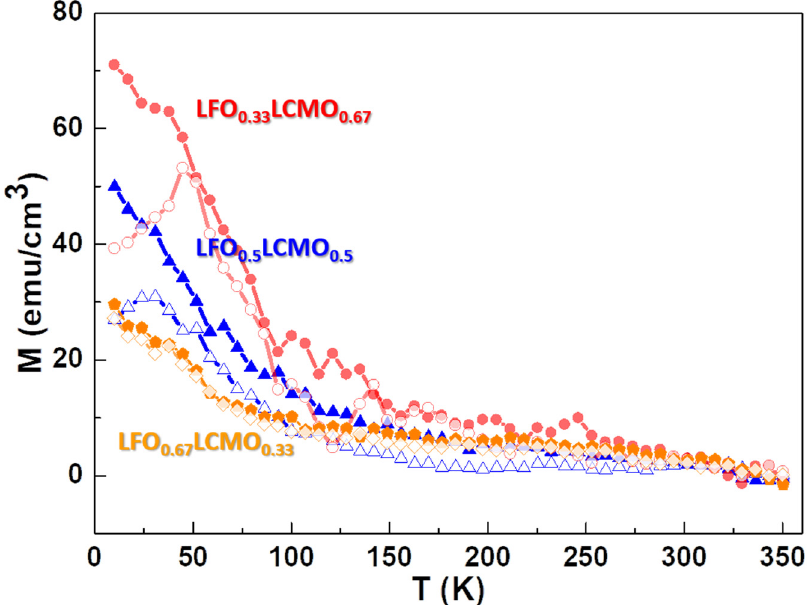
Figure 5. Temperature dependence of zero-field cooling (ZFC, solid symbols) and field cooling (FC, 1000 Oe, hollow symbols) magnetization of all the samples with different compositions.